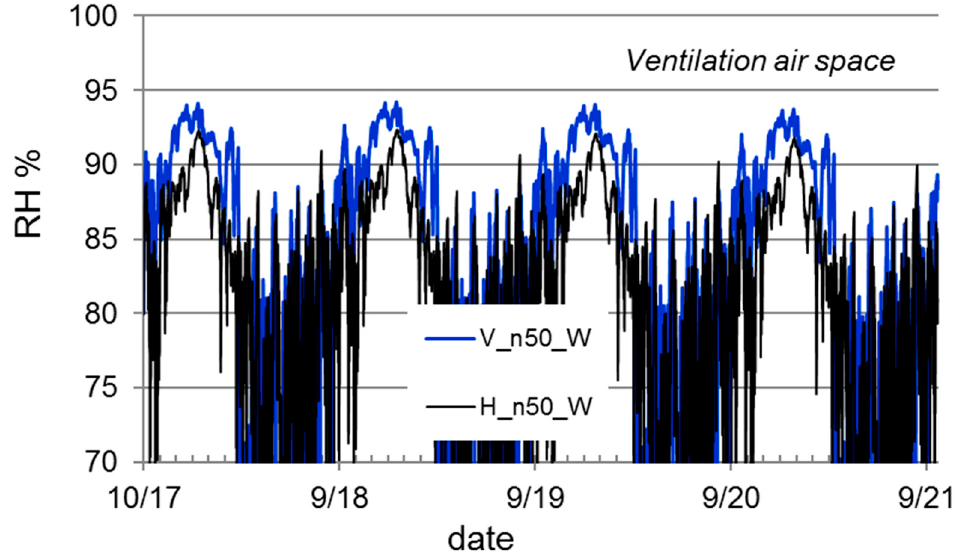
Figure 19. Concrete sandwich wall, wet exterior core, ventilation scheme 1, n = 50 1 / h. The relative humidity in the ventilation air space in two climates during the four-year simulation period.